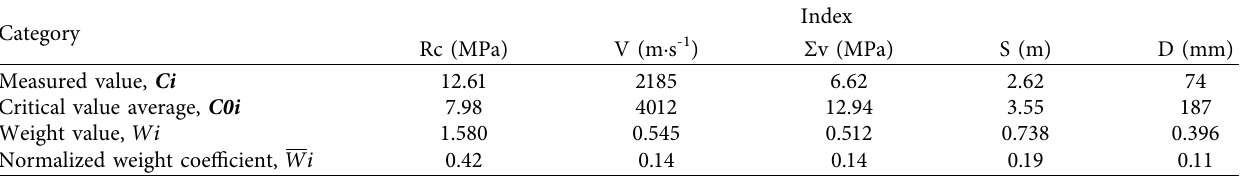
Table 7: Weight table of the classification index for measured value of roof damage